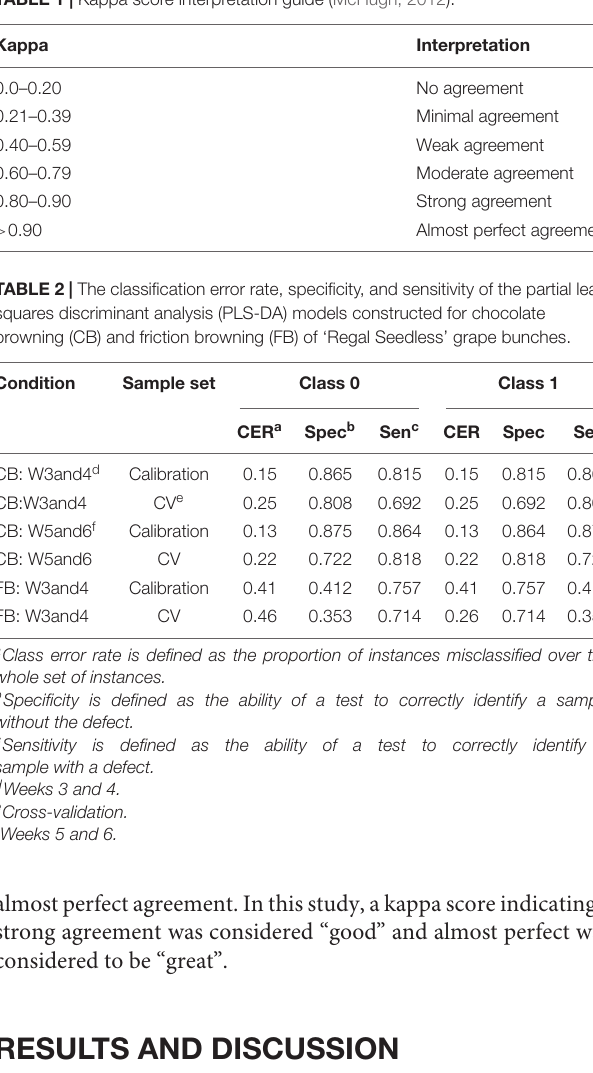
TABLE 1 | Kappa score interpretation guide (McHugh, 2012).